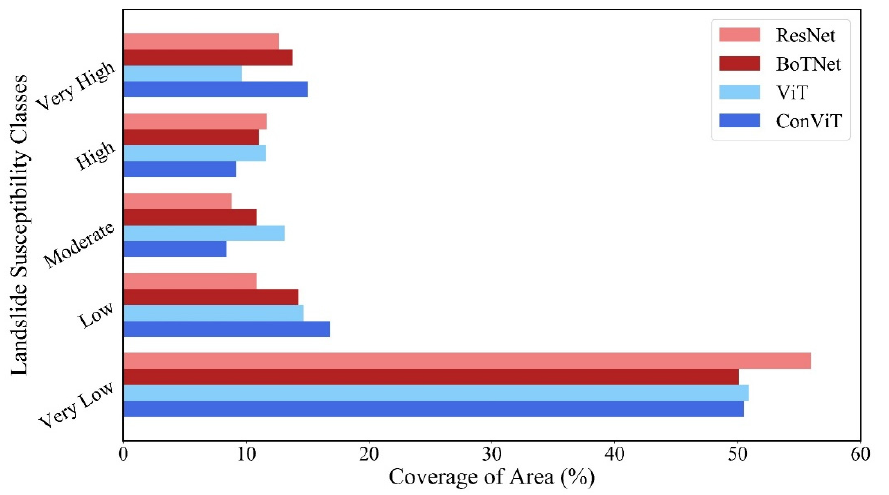
Figure 10. Landslide probability rating of the study area.